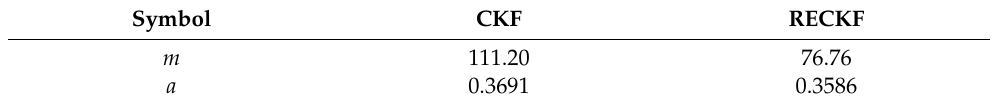
Table 4. The RMSE in the case of acceleration.